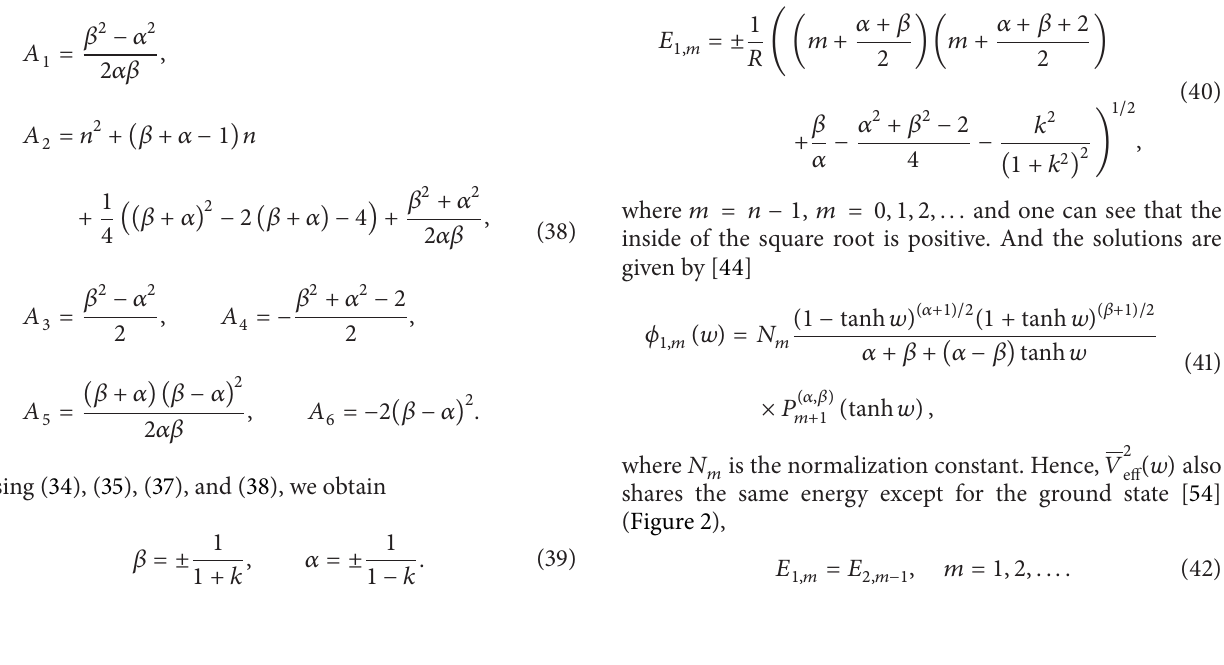
1 can be obtained as given in eff